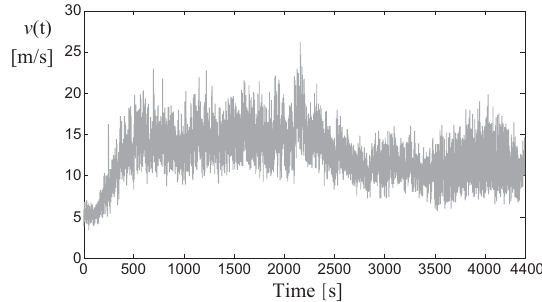
Figure 2. The wind speed sequence v ( t ) used in the benchmark model.